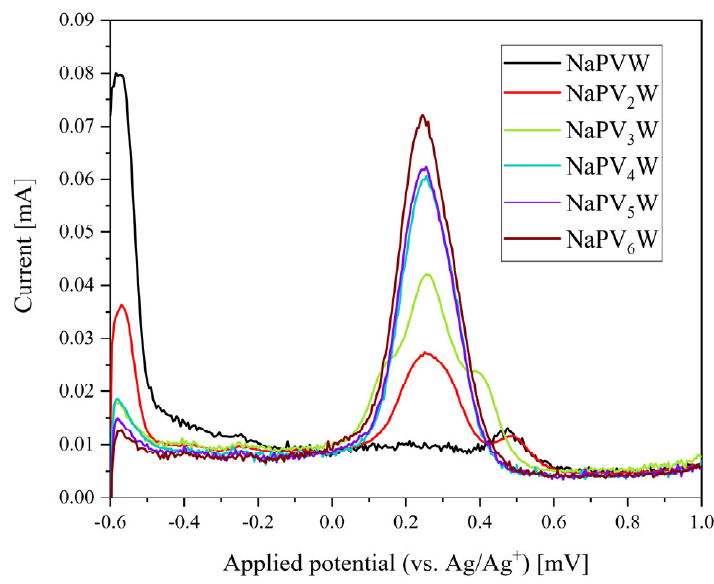
Figure 13. SWV data of the POMs NaPV x W, with x = 1 to 6 (concentration 1 mmol/L, scan rate 5 mV and pH 1 (HCl as supporting electrolyte)).